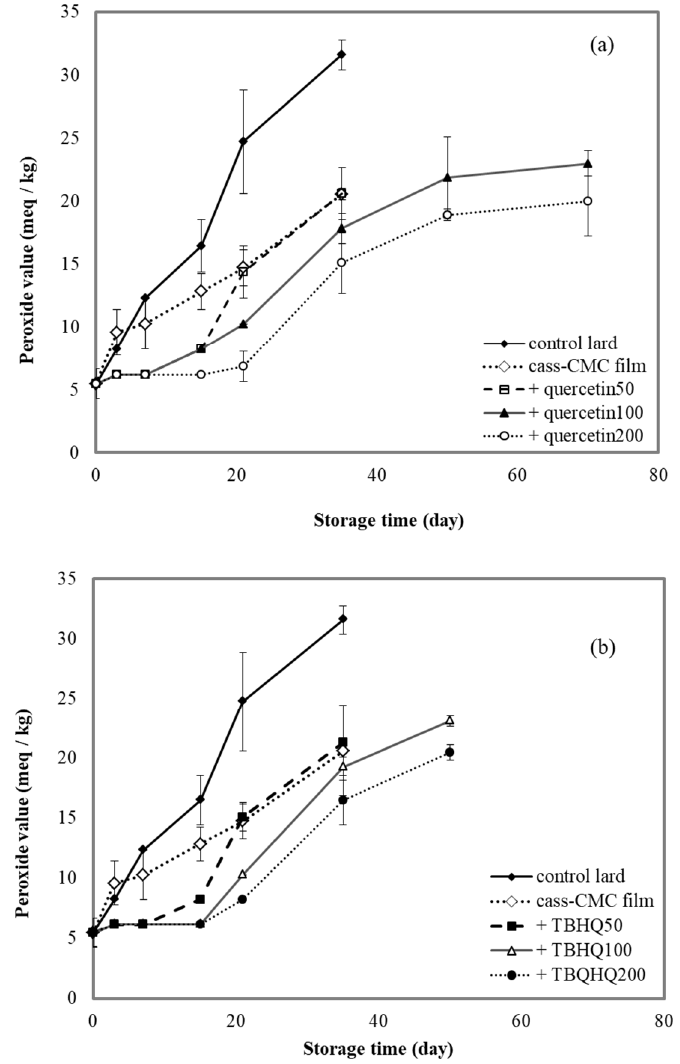
Figure 7. Effect of ( a ) quercetin and ( b ) TBHQ content in cassava starch–CMC films on peroxide value of lard.